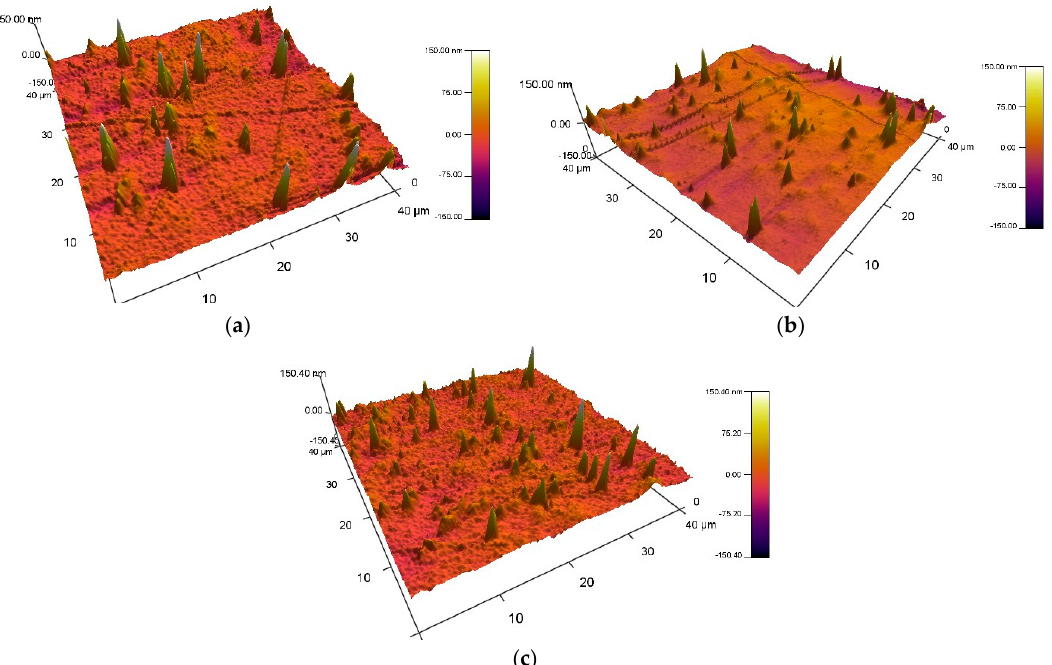
Figure 3. 3D topography of ZGO films with the corresponding root mean square (RMS) roughness and sputtering voltage: ( a ) RMS roughness 16.77 nm, 0.5 kV; ( b ) RMS roughness 15.56 nm, 0.9 kV and ( c ) RMS roughness 12.90 nm, 1.1